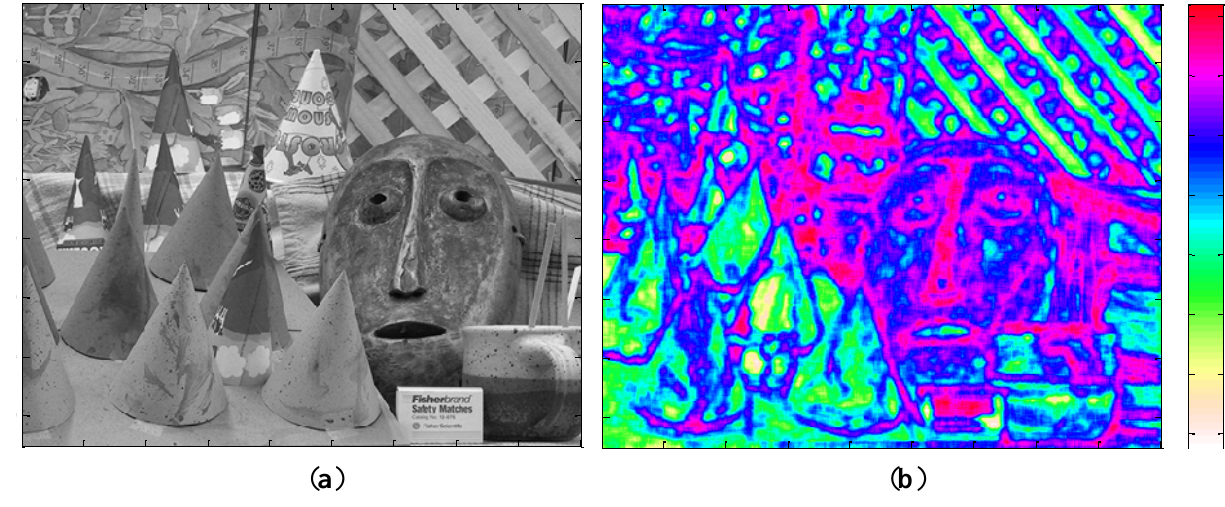
Figure 4. ( a ) Original image. ( b ) Corresponding entropy